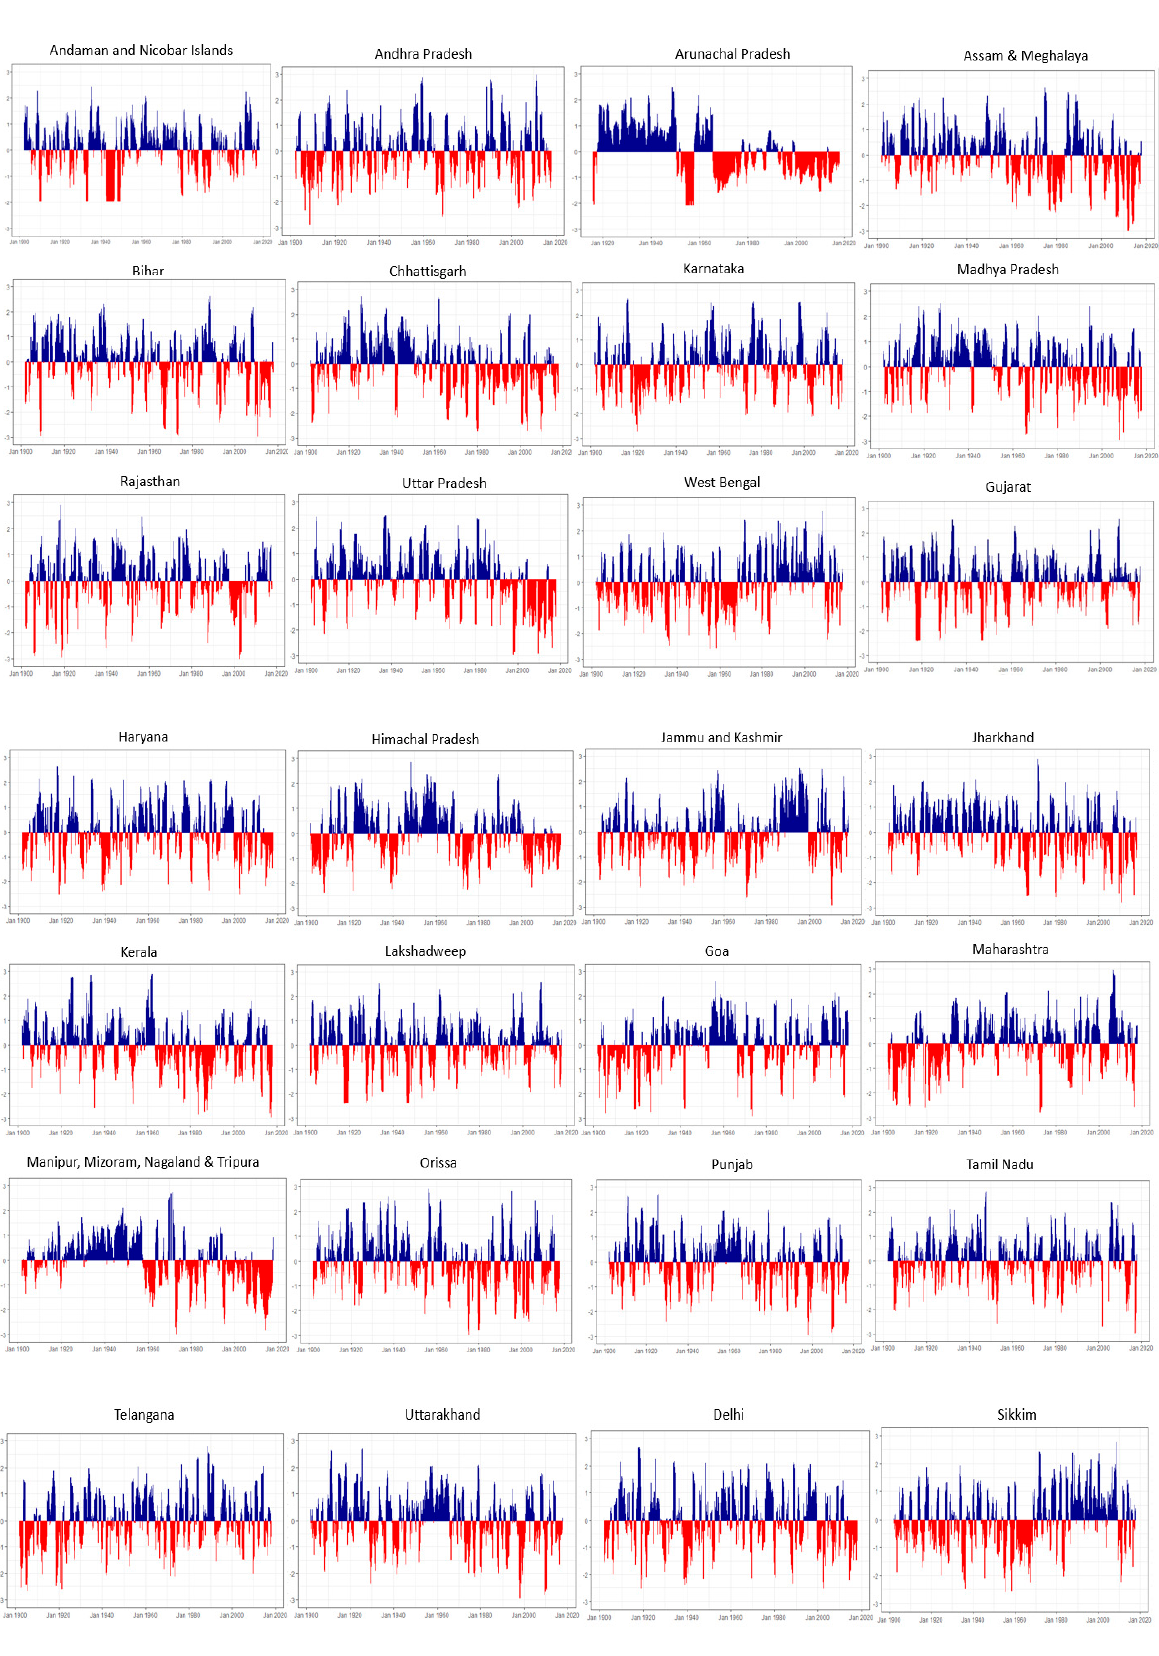
Figure 7. Drought estimation from 1901 to 2017 for various regions in India; x -axis specifies the year and y -axis the SPI value (red indicates drought and blue is wet).